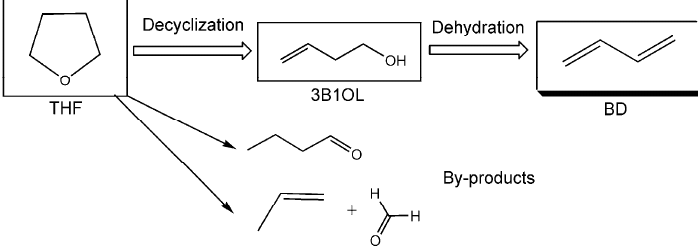
Figure 4. Synthesis of BD from THF through the intermediate 3-buten-1-ol (3B1OL), and the by-products in the decyclization of THF [70].